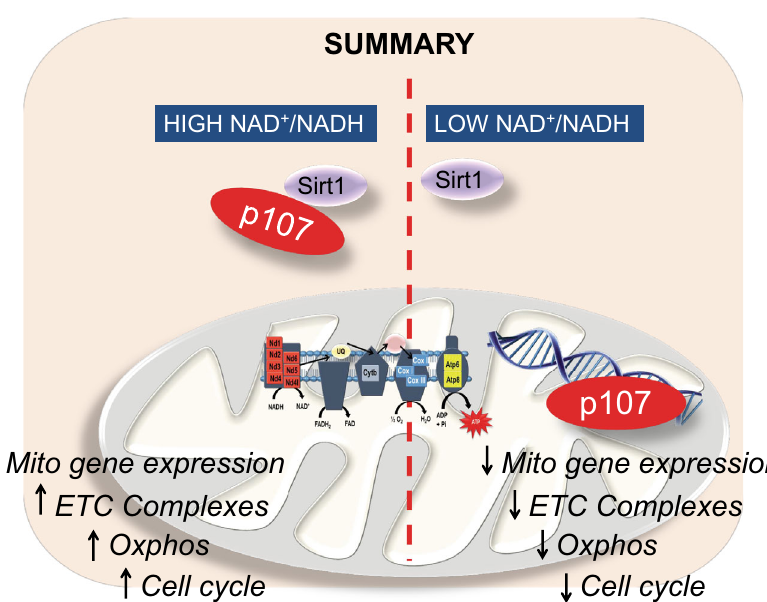
Fig. 6 Schematic for p107 regulating muscle progenitor (MP) proliferation based on Sirt1 activity. When the cytoplasmic NAD + /NADH ratio is high, Sirt1 is active interacting with p107 preventing its mitochondrial localization. This causes de-repression of the mitochondrial-encoded genes, thus enhancing Oxphos generation that increases MP proliferation rate. Contrarily, with low NAD + /NADH ratio, Sirt1 is inactive and p107 is free to relocate to the mitochondria, where it interacts with the mitochondrial DNA to repress its gene expression. This causes downregulation of mitochondrial Oxphos that decelerates MP cell cycle progression and proliferation